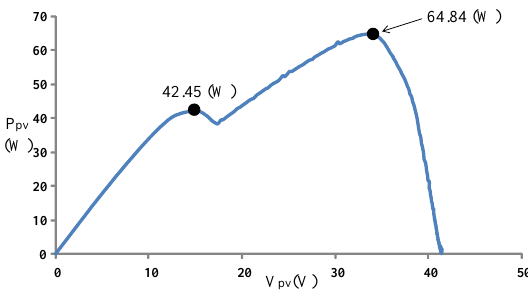
Figure 18. P–V characteristic curve of Case 4.